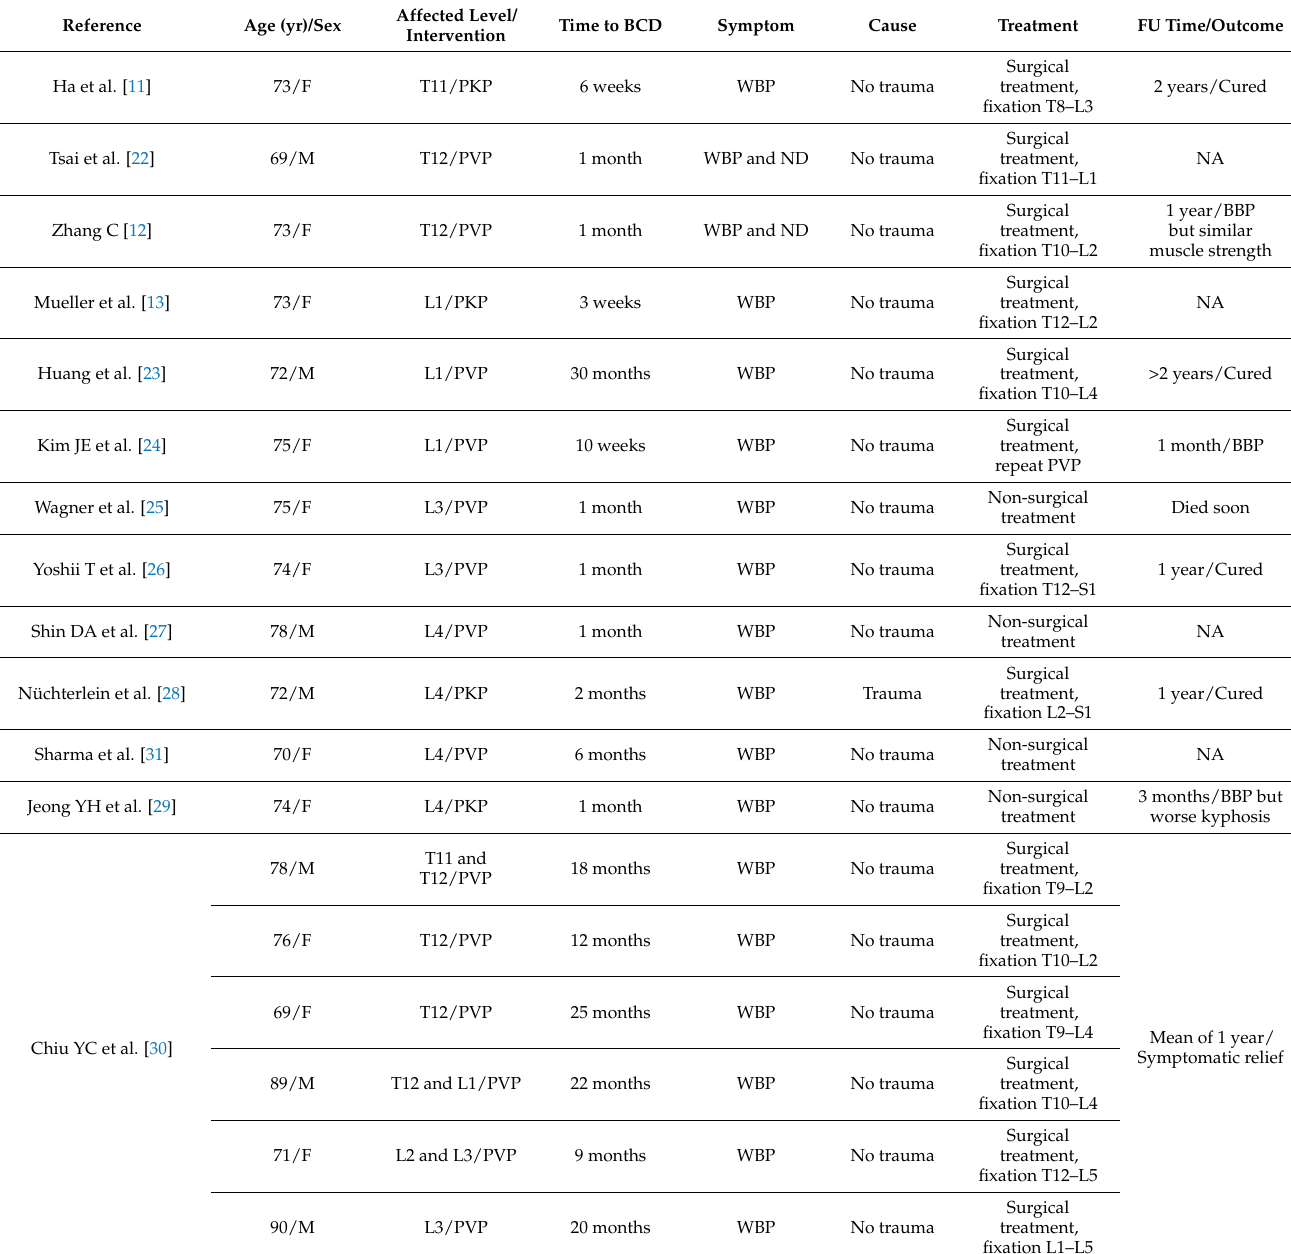
Table 5. Summary of the reported cases suffering symptomatic BCD after PKP or PVP from